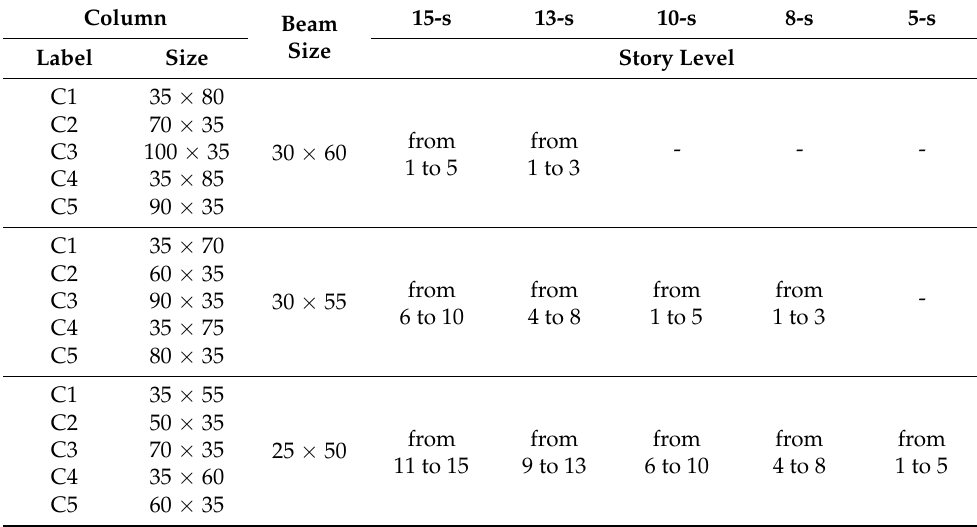
beams and 0.7EI g for columns (E: Concrete modulus of elasticity and I g is moment of in- ertia for gross section). Several plastic hinge lengths have been proposed in the literature. For this study, half of the section depth is used for the plastic hinge length value as recommended in TBEC-2018.